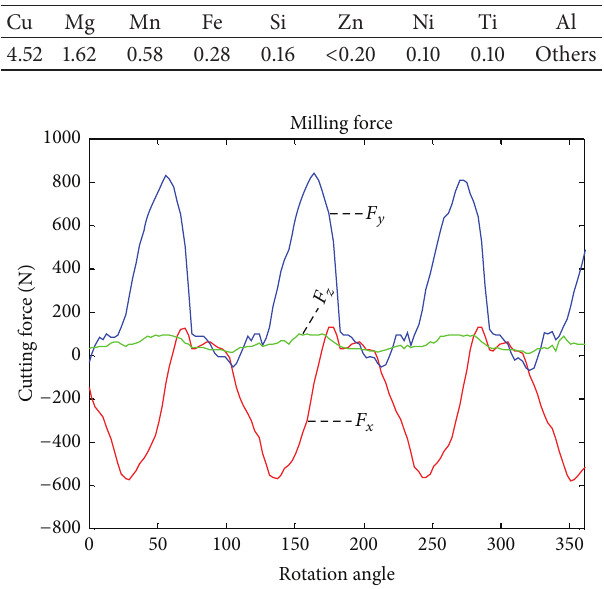
Figure 6: Cutting force in x / y / z direction (cutting speed 125 m/min, cutting depth 4 mm, and the feed 100mm/min).